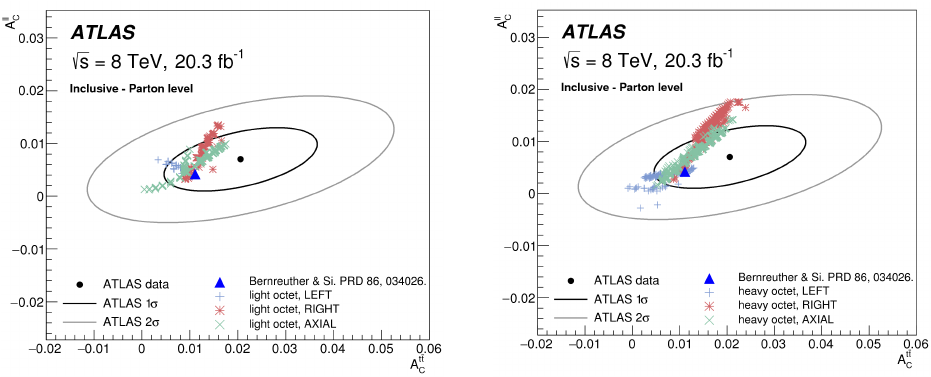
Figure 11. Comparison of the A (cid:96)(cid:96) and A t ¯ t inclusive results in the full phase space with the SM NLO C C QCD+EW predictions [14] and two BSM benchmark scenarios [43]. Ellipses correspond to the 1 and 2 σ total measurement